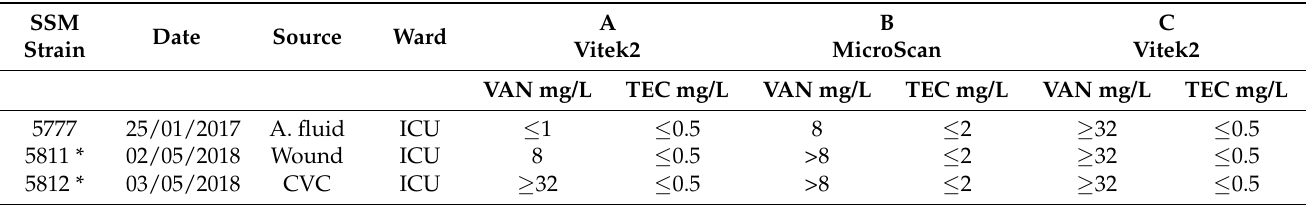
Table 2. Features and levels of vancomycin resistance mediated by vanB 2 -VREfm. Glycopeptides MICs are given before (A, B) and following (C) exposure to 100mg/L of